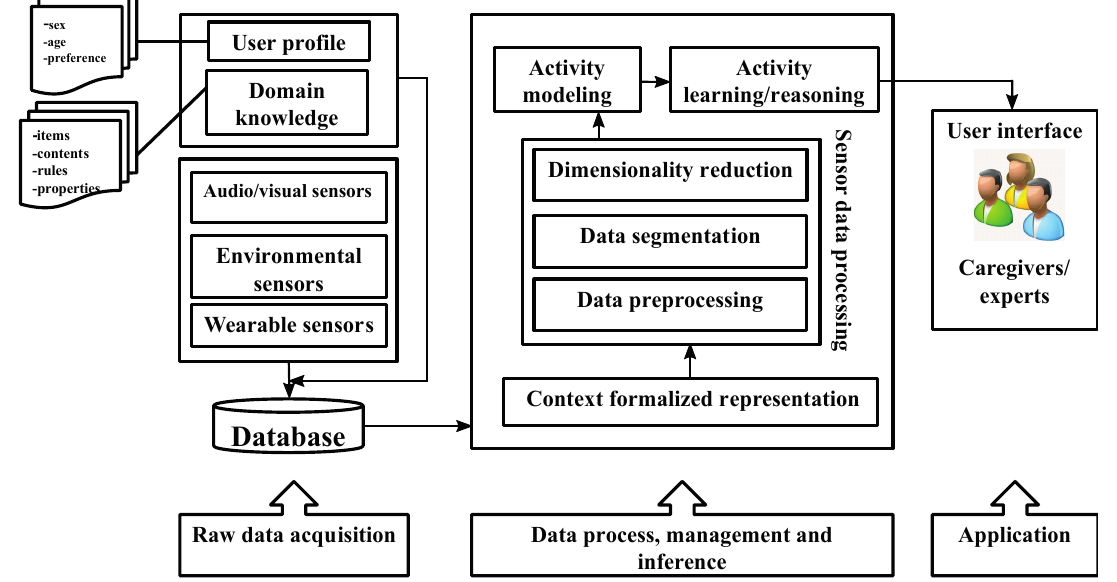
Figure 1. Overall architecture of activity monitoring systems in smart home